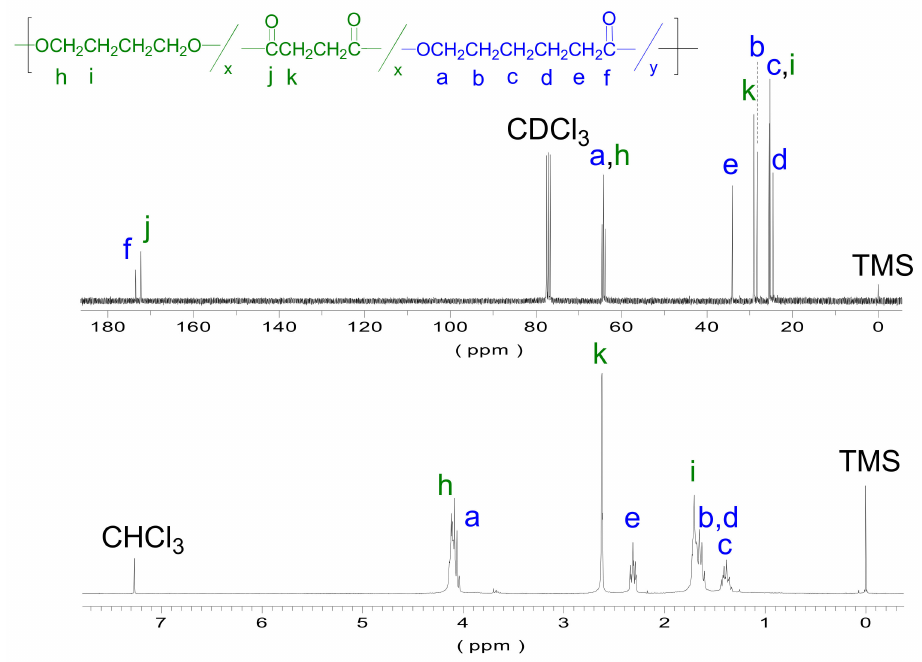
Figure 5. 1 H (bottom) and 13 C (top) NMR spectra of PBS 50 CL 50 recorded in CDCl 3 with peak